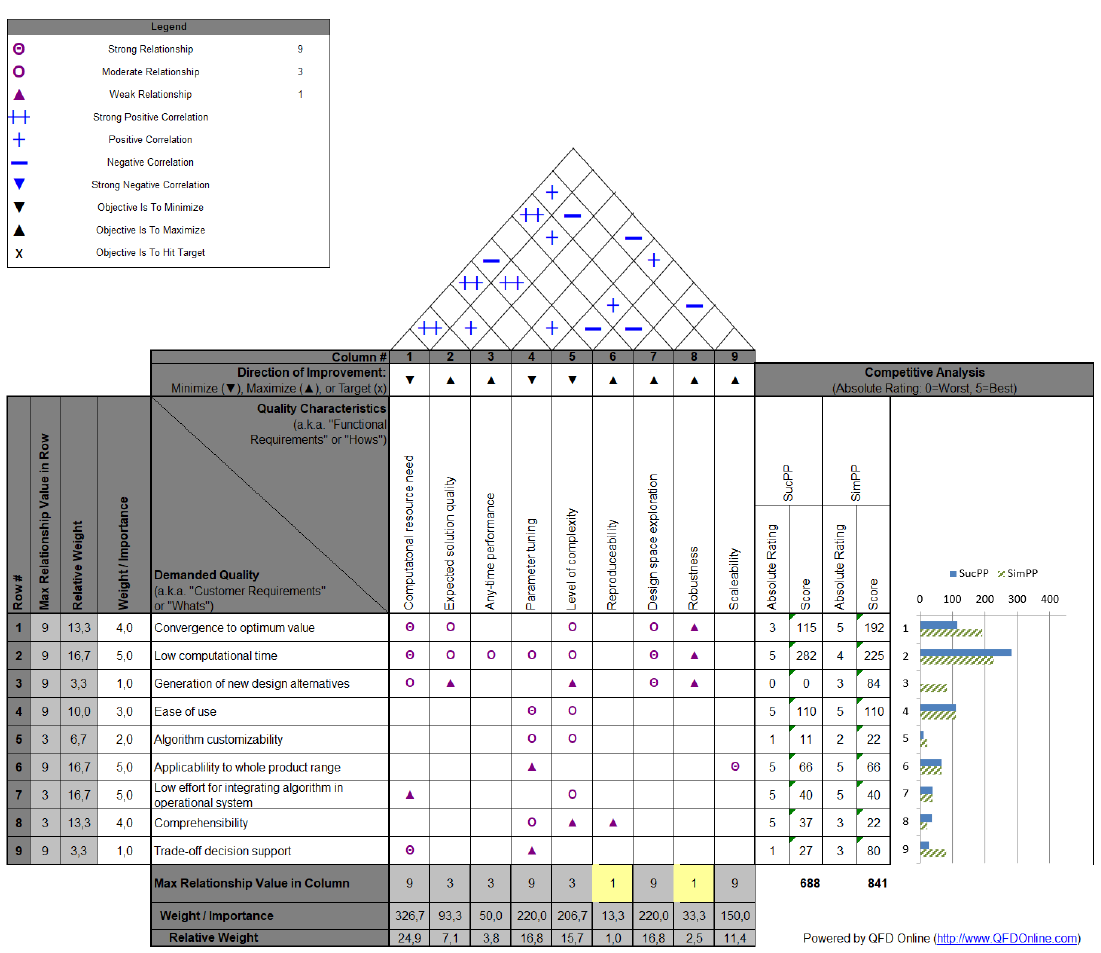
Figure 2. Design optimization decision matrix